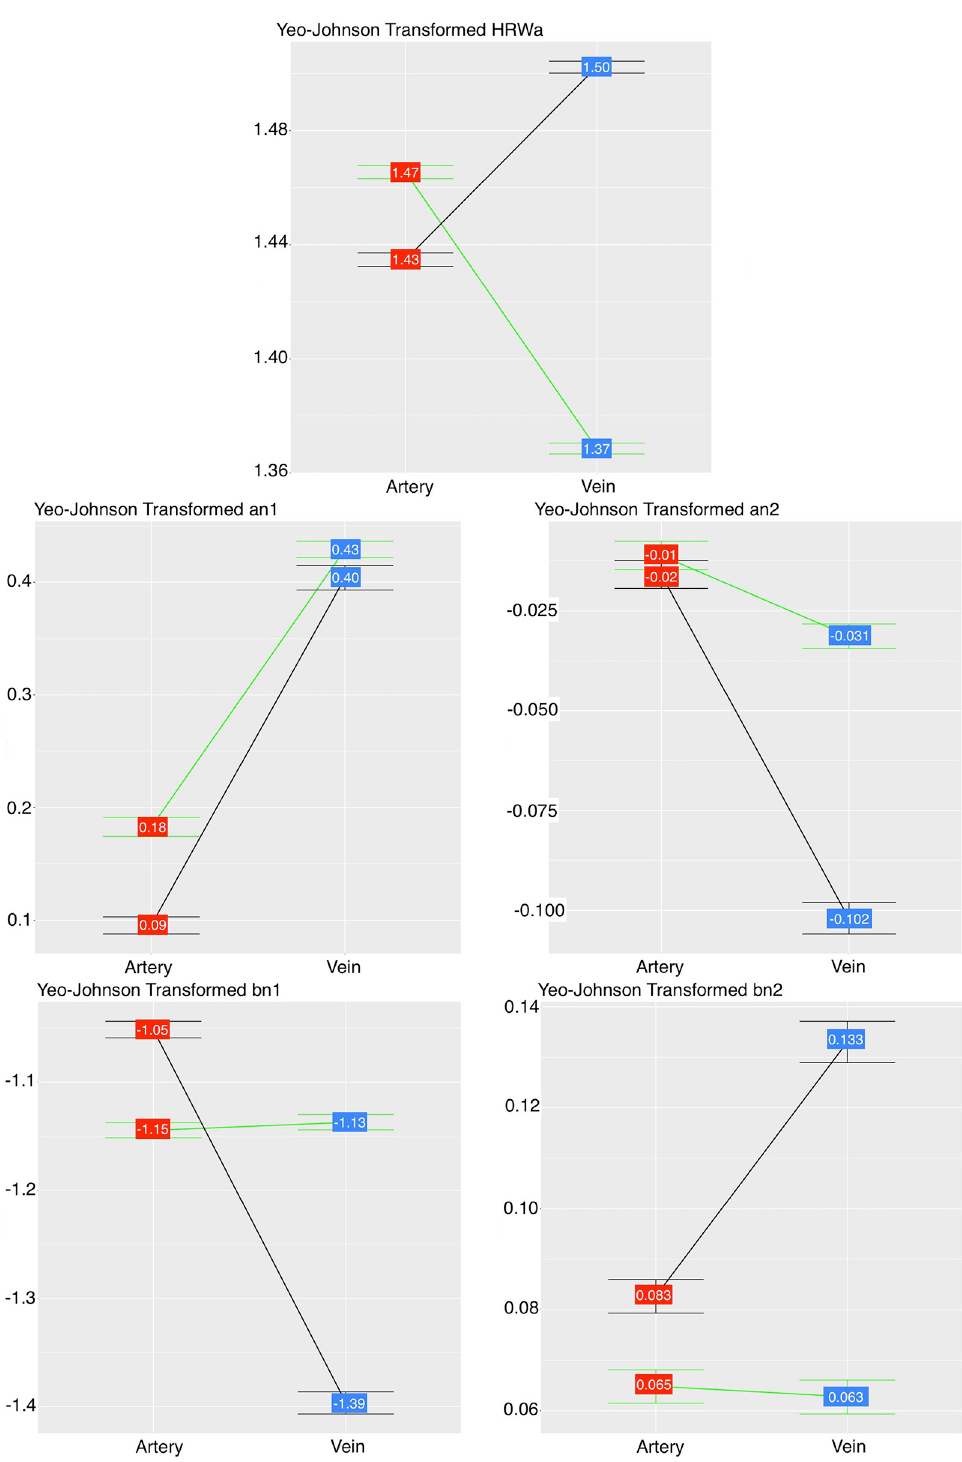
Fig 5. Interaction plot of the harmonic regression waveform amplitude (HRW a ), cosine (a n1,2 ) and sine (b n1,2 ) coefficients of the first and second harmonics. In both the high (h) and normal (n) intracranial pressure groups for both vascular systems there was interaction of the HRW a and b n1 , no interaction of the a n1 term and ordinal interaction of the a n2 and b n2 terms. Therefore the sine coefficient (b n1 ) and the second harmonic coefficients reflects the retinal vascular pulse response to ICP and the cosine coefficient (a n1 ) follows the IOP pulse wave response on the vessel wall. Color code: green = ICP h , black = ICP n study